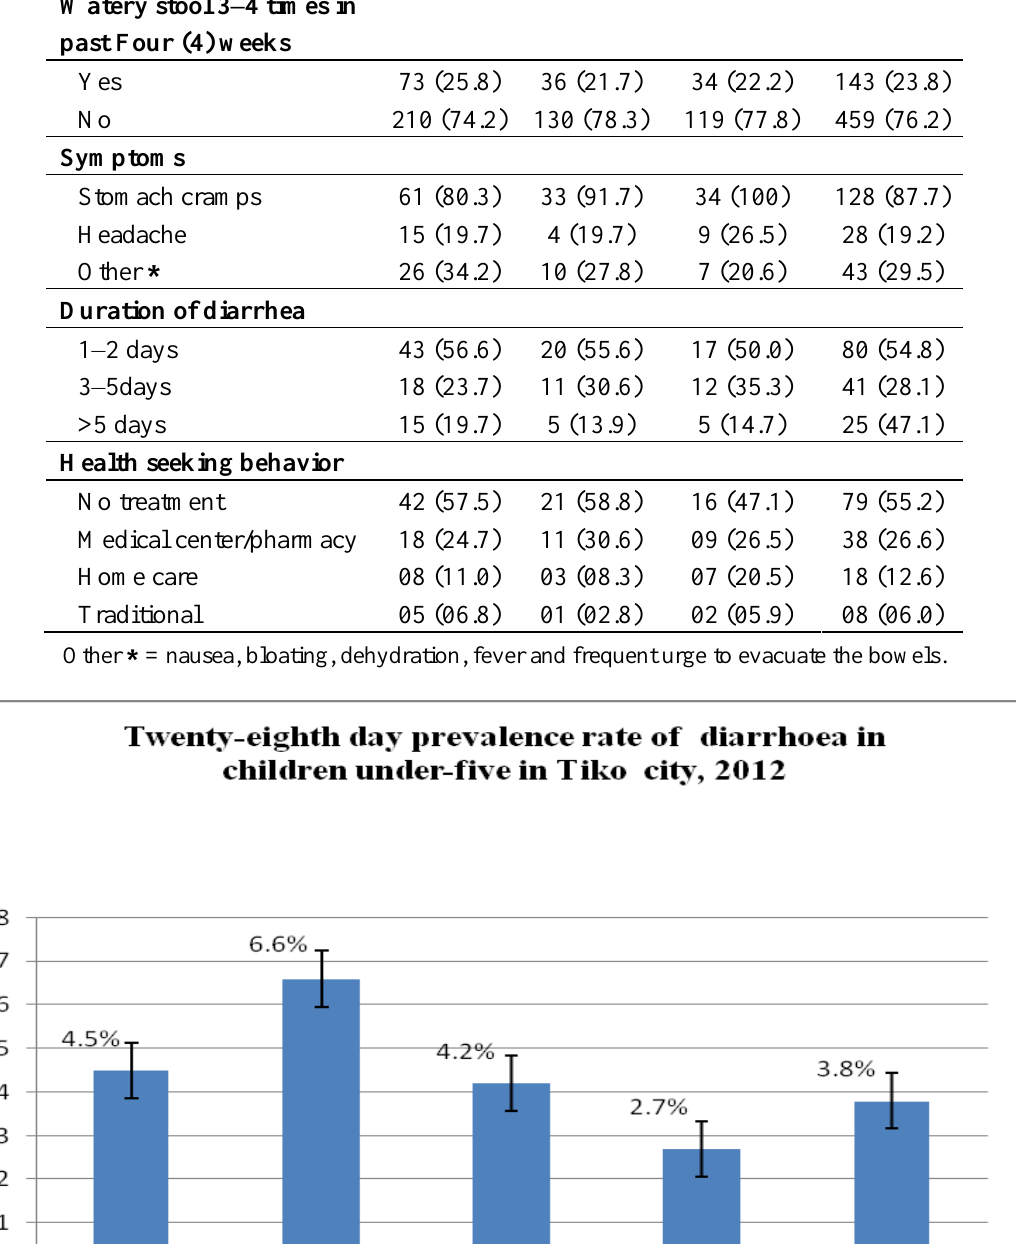
Table 3. The health Characteristics of children under five years in Tiko, 2012. Characteristics